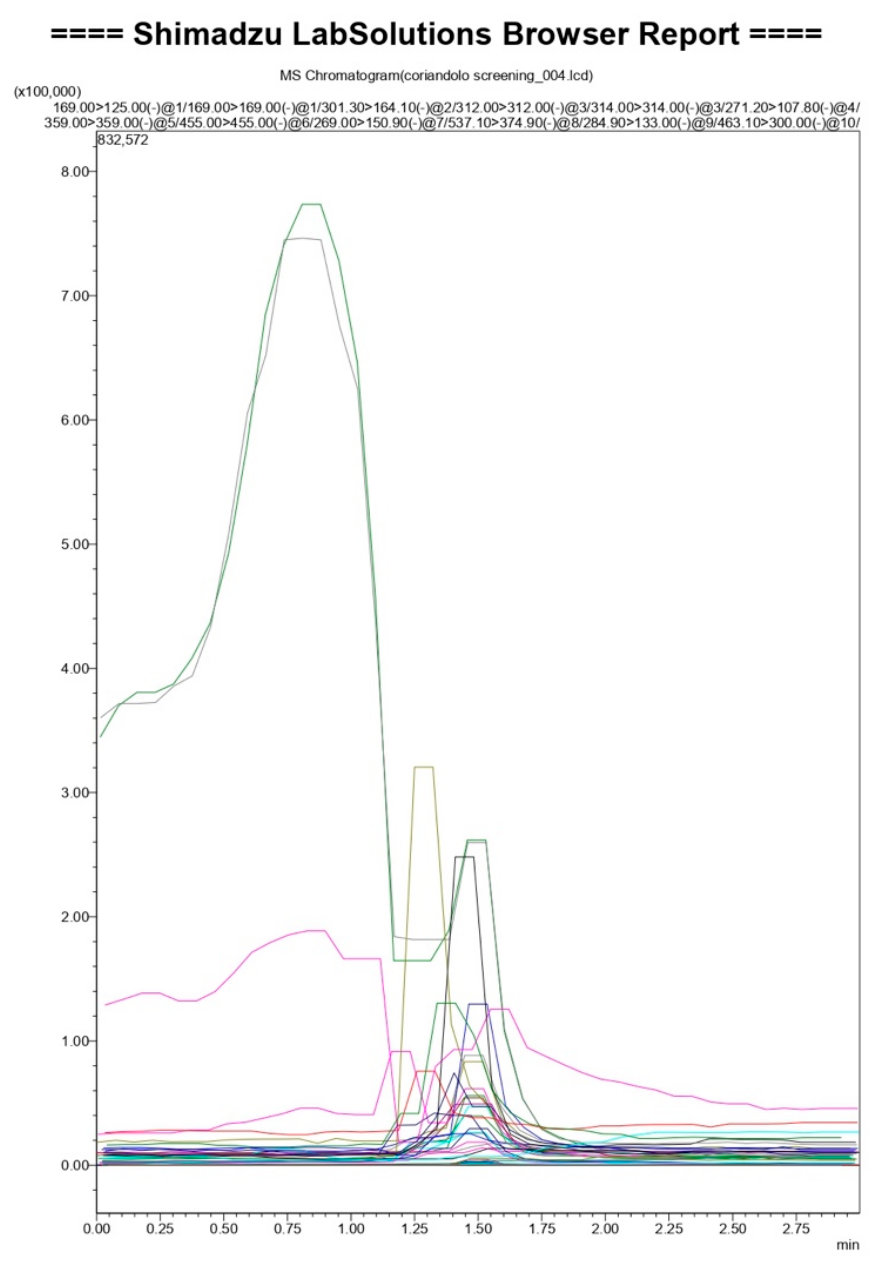
Figure 1. Selected fragments derive from the molecular weight of the polyphenol minus one (due to ESI- ionization) and their subsequent fragmentation in MS/MS experiment. Notes: Vanillic acid in black, Chlorogenic acid in violet, Catechin/Epicathechin in dark blue, Oleuropein in dark green, Epicathechin gallate in brown, Rutin in light green, Gallocathechin/Epigallocathechin in light blue.